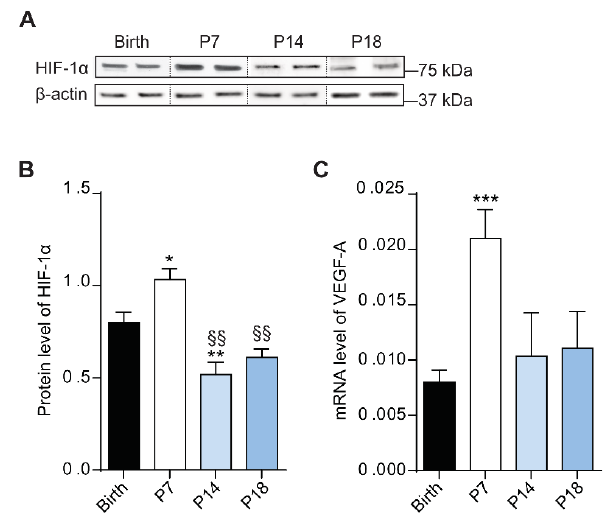
Figure 3. Protein levels of hypoxia-inducible factor (HIF) change during rat retina development. ( A ) Western blots illustrate representative immunoreactive bands of HIF-1α and β-actin (loading